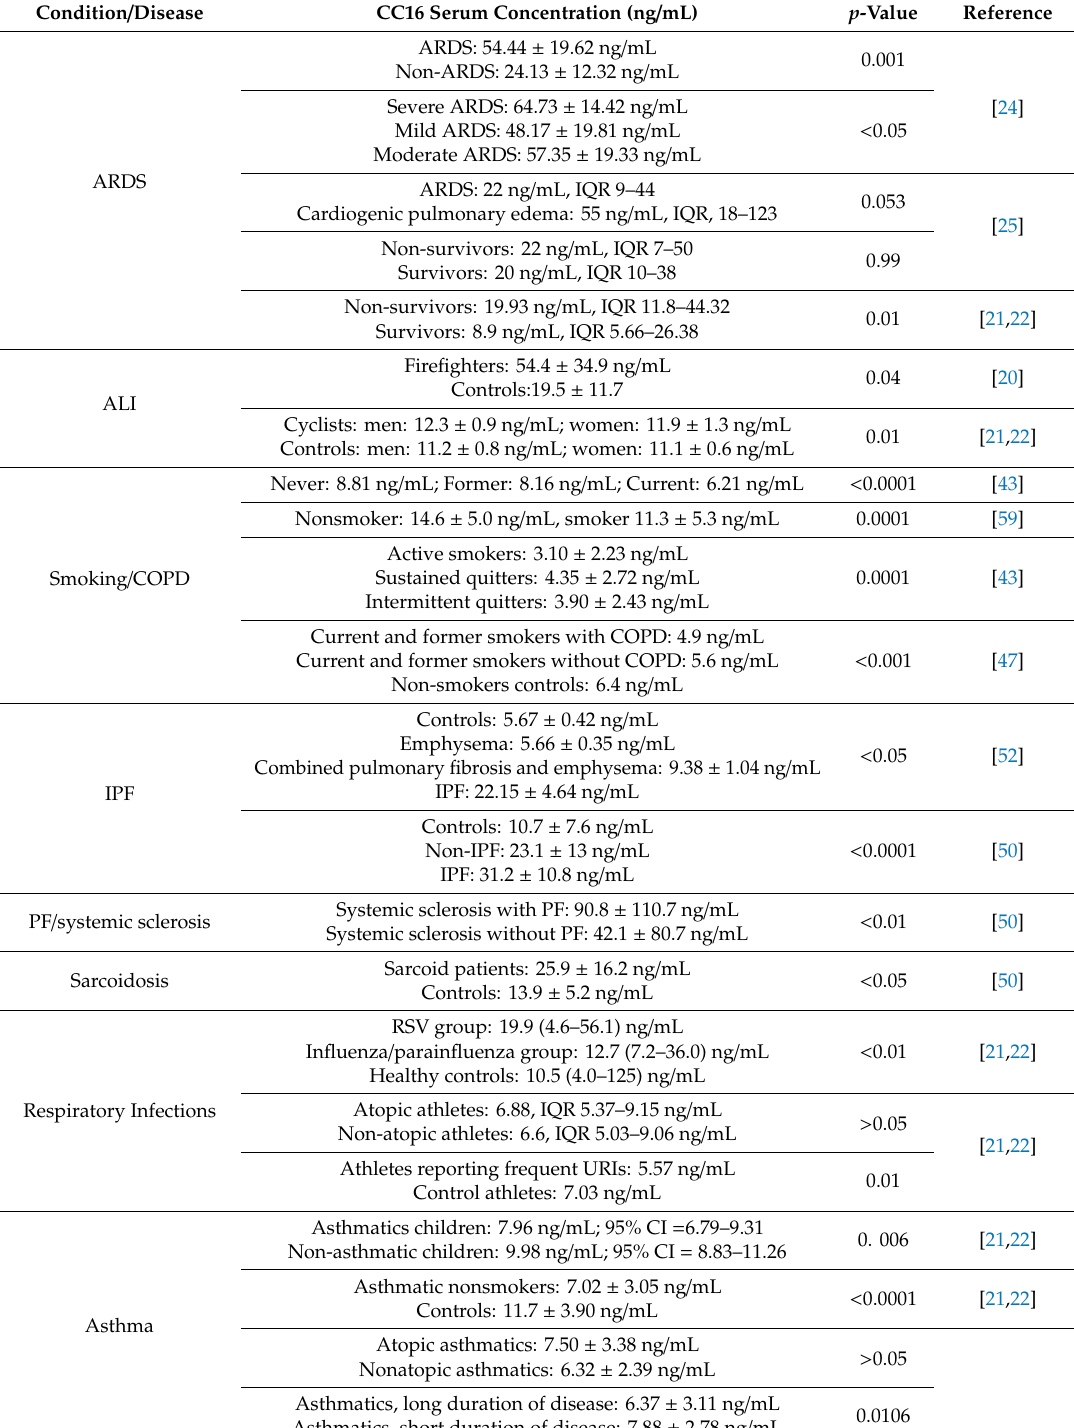
Table 2. Serum CC16 concentration in various conditions or diseases. Condition /